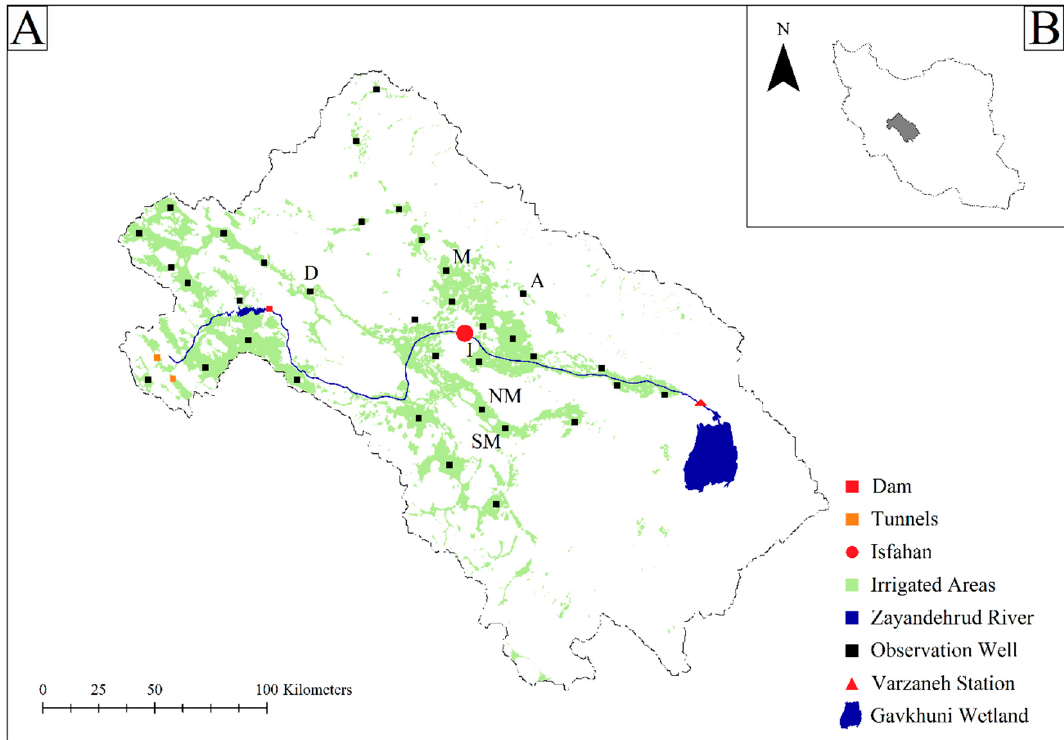
Figure 1. ( A ) Zayanderud River Basin with layout of the irrigated areas, groundwater aquifers observation wells, tunnels, Varzaneh station and the location of the Gavkhuni Wetland. ( B ) The location of the Zayanderud Basin in Iran. The figure also shows the position of observation wells with the highest depletion rate: NM: North Mahyar, SM: South Mahyar, D: Damaneh, I: Isfahan, M: Murchehkhort and A: Ardestan.